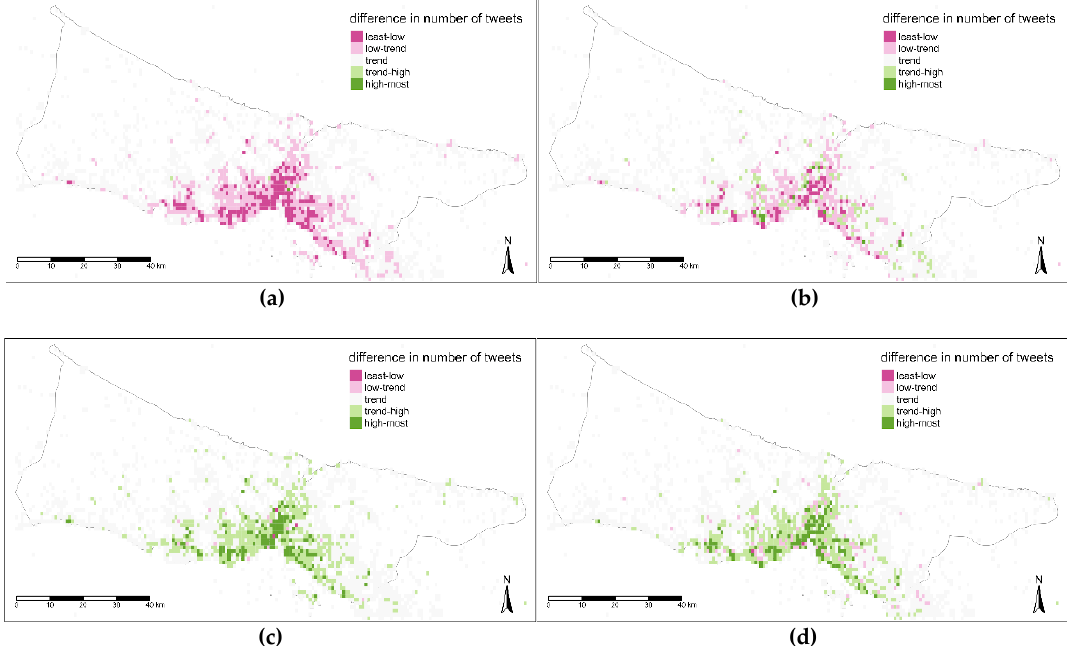
Figure 14. Difference in the number of tweets between time level 1 and trend maps (a) night; (b) before Figure 14. Di ff erence in the number of tweets between time level 1 and trend maps ( a ) night; ( b ) before midday; (c) after midday; (d) evening. midday; ( c ) after midday; ( d )